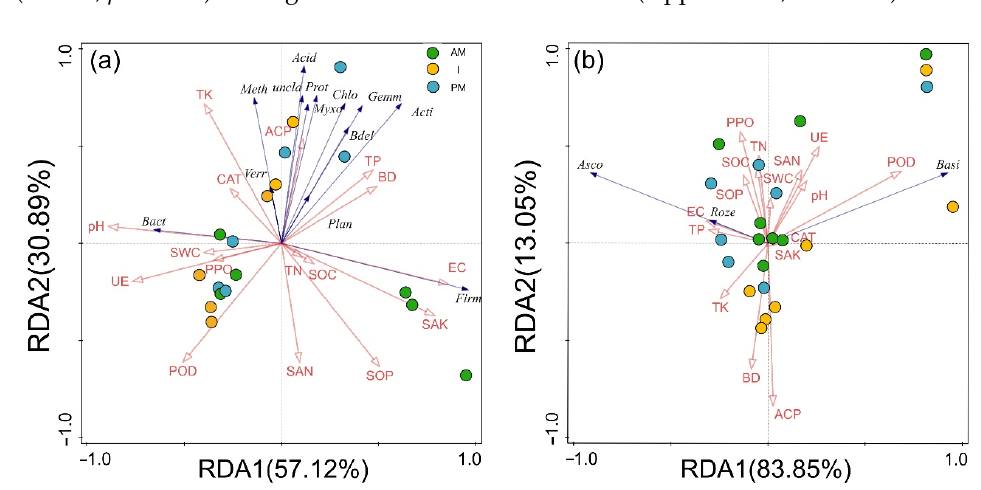
Figure 8. Ordination plots of the results from the redundancy analysis (RDA) to identify the re- lationships among the microbial (bacterial and fungal) taxa (blue arrows) and the soil properties and enzyme activities (red arrows) at the phylum level. ( a ) Relationships between soil bacterial communities and environmental variables and ( b ) relationships between soil fungal communities and environmental variables. Bacterial taxa: Proteobacteria (Prot), Actinobacteriota (Acti), Aci- dobacteriota (Acid), Firmicutes (Firm), Chloroflexi (Chlo), Bacteroidota (Bact), Myxococcota (Myxo), Methylomirabilota (Meth), Verrucomicrobiota (Verr), Gemmatimonadota (Gemm), Planctomycetota (Plan), and Bdellovibrionota (Bdel). Fungal taxa: Ascomycota (Asco), Rozellomycota (Roze), and Basidiomycota (Basi). Soil properties: electrical conductivity (EC), soil water content (SWC), soil bulk density (BD), soil organic carbon (SOC), soil-available potassium (SAK), soil-available phosphorus (SAP), alkali-hydrolyzed nitrogen (SAN), total nitrogen (TN), total phosphorus (TP), total potassium (TK), soil catalase (CAT), soil polyphenol oxidase (PPO), soil peroxidase (POD), soil acid phosphatase (ACP), and soil urease (UE). Same